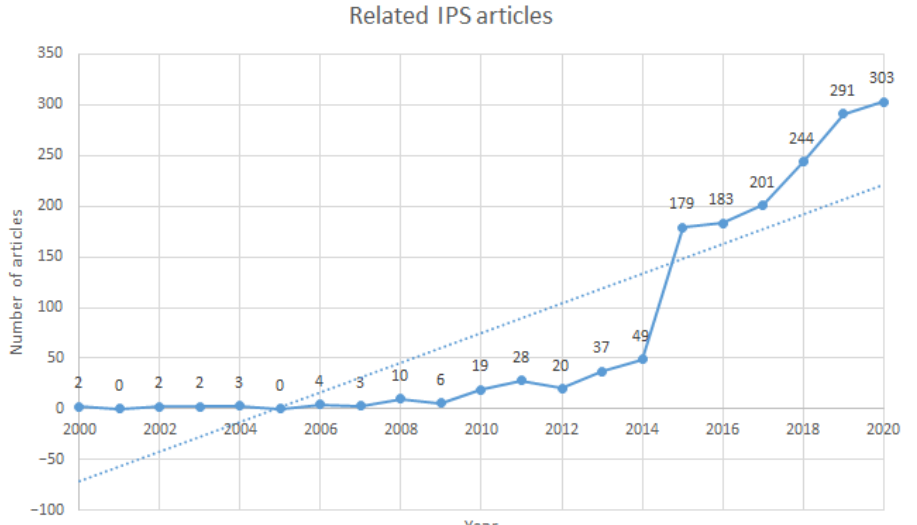
Figure 1. Works related to IPS between 2000 and